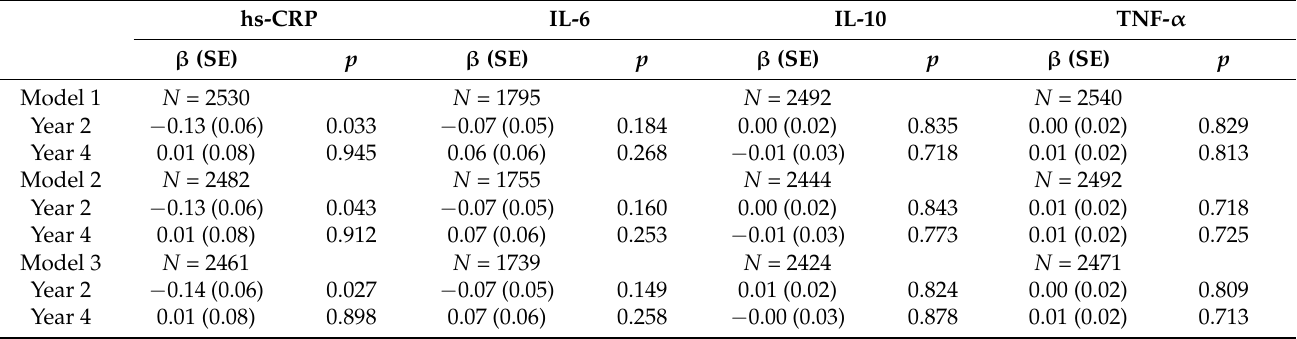
Table 4. Compliance-adjusted analysis of vitamin D 3 supplementation on log-transformed inflamma- tory markers.